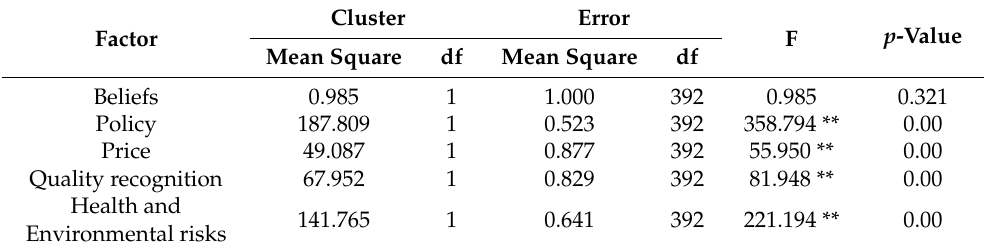
Table 6. K-means cluster analysis: ANOVA results.